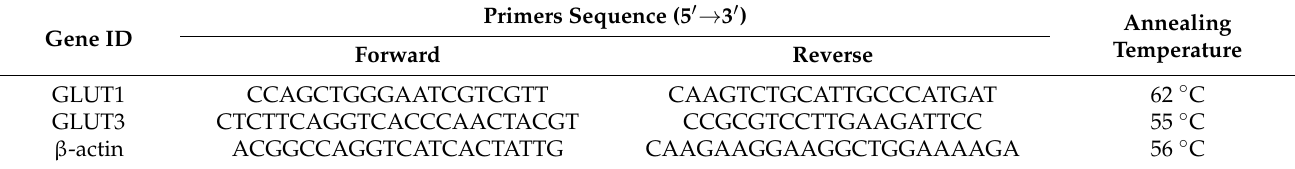
Table 1. Primer sequences of the assessed genes used in